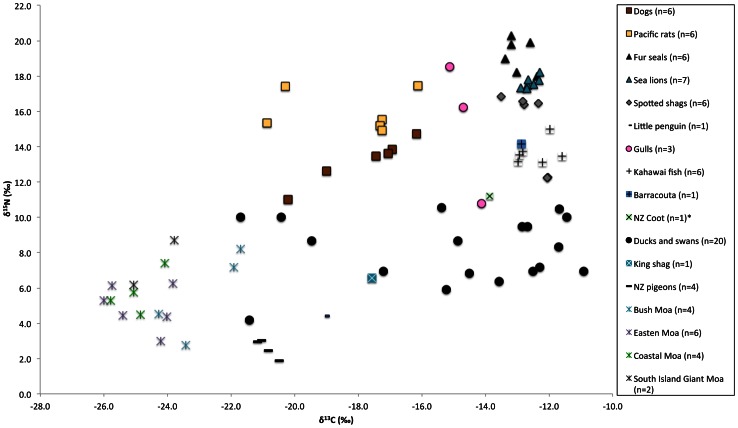
Wairau Bar faunal bone collagen δ13C and δ15N values.